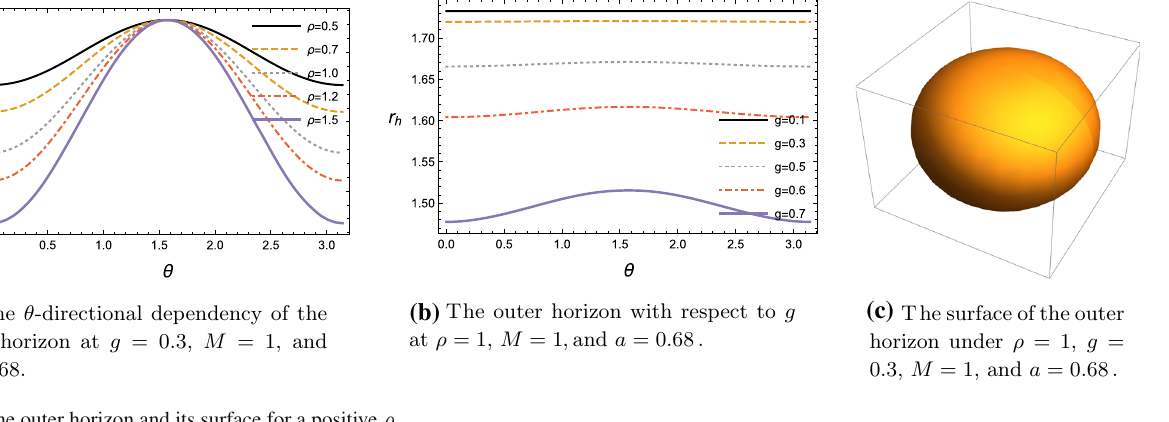
The outer horizon with respect to g 68., at ρ = 1, M = 1 and a = 0 . 68.